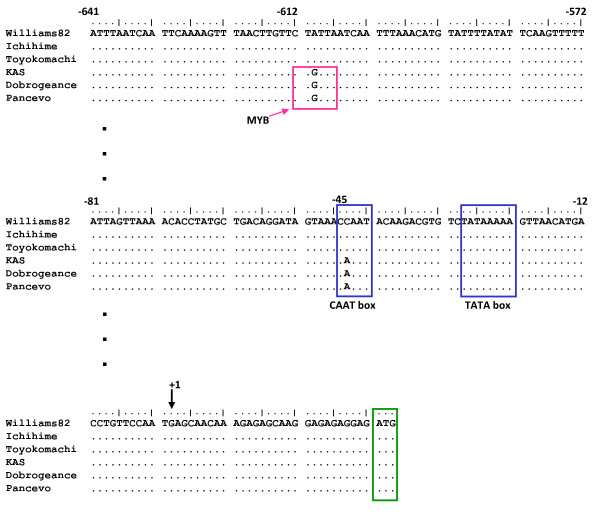
Predicted transcription factor binding motifs in 5'-upstream sequence of γ-TMT3. The 5'-upstream sequence of γ-TMT3 was isolated from high α-tocopherol soybeans (KAS, Dobrogeance, and Dobrudza 14 Pancevo [Pancevo]), and typical cultivars (Williams 82, Ichihime, and Toyokomachi). Cis-element motifs were predicted by using the PLACE [39] and PLANTCARE databases [40]. Only motifs where nucleotide polymorphisms occur are shown. CAAT: common cis-acting and enhancer; MYB: binding site for MYB transcription factor. ATG surrounded by green box indicates translation start site. +1 indicates transcriptional start site (TSS). Numbers above the nucleotides refer to the distance from the TSS. Vertical rows of dots represent promoter regions not shown in the figure.